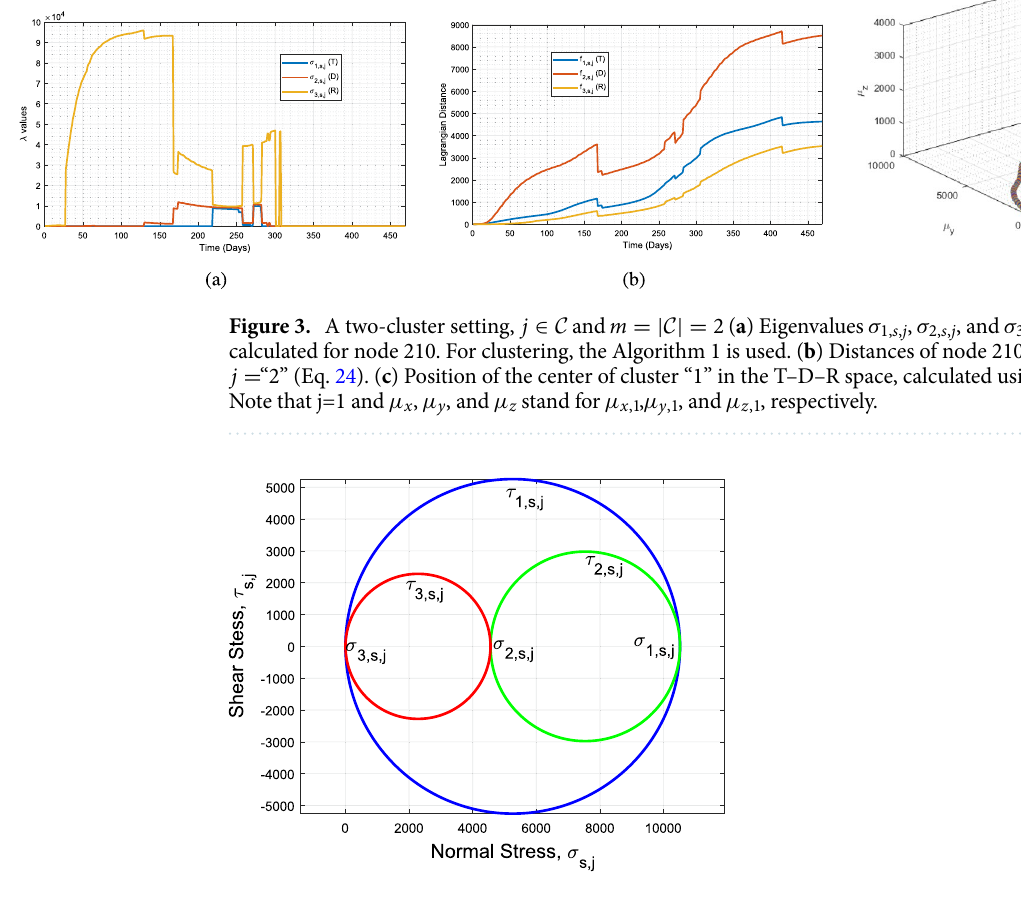
Figure 4. Sample Mohr’s circle for node S j = 80 and for day k = 220 and cluster j=1 for j ∈ C and m = 2